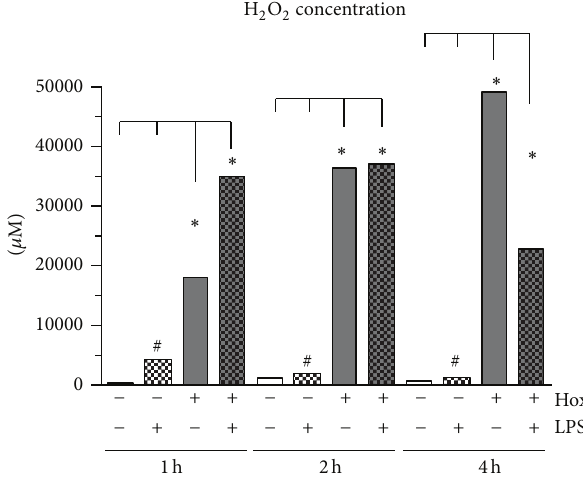
Figure 2: Determination of ROS formation (H 2 O 2 ) using Amplex Red assay. PDL cells were cultured under normoxic (Nox) or hypoxic condition (Hox) and stimulated with or without LPS of Porphyromonas gingivalis (1 𝜇 g/mL). H 2 O 2 was analyzed after 1, 2 and 4 hours. Statistical differences were analyzed by one-way ANOVA and post hoc Dunnett and Tukey’s multiple comparison test; # 𝑃 < 0.05 difference to control; ∗ 𝑃 < 0.05 difference between groups (means ± SD; 𝑛 = 6